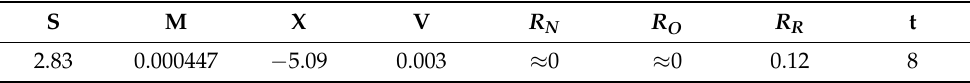
Table 2. Coefficients of each variable when using all eight features in Lasso